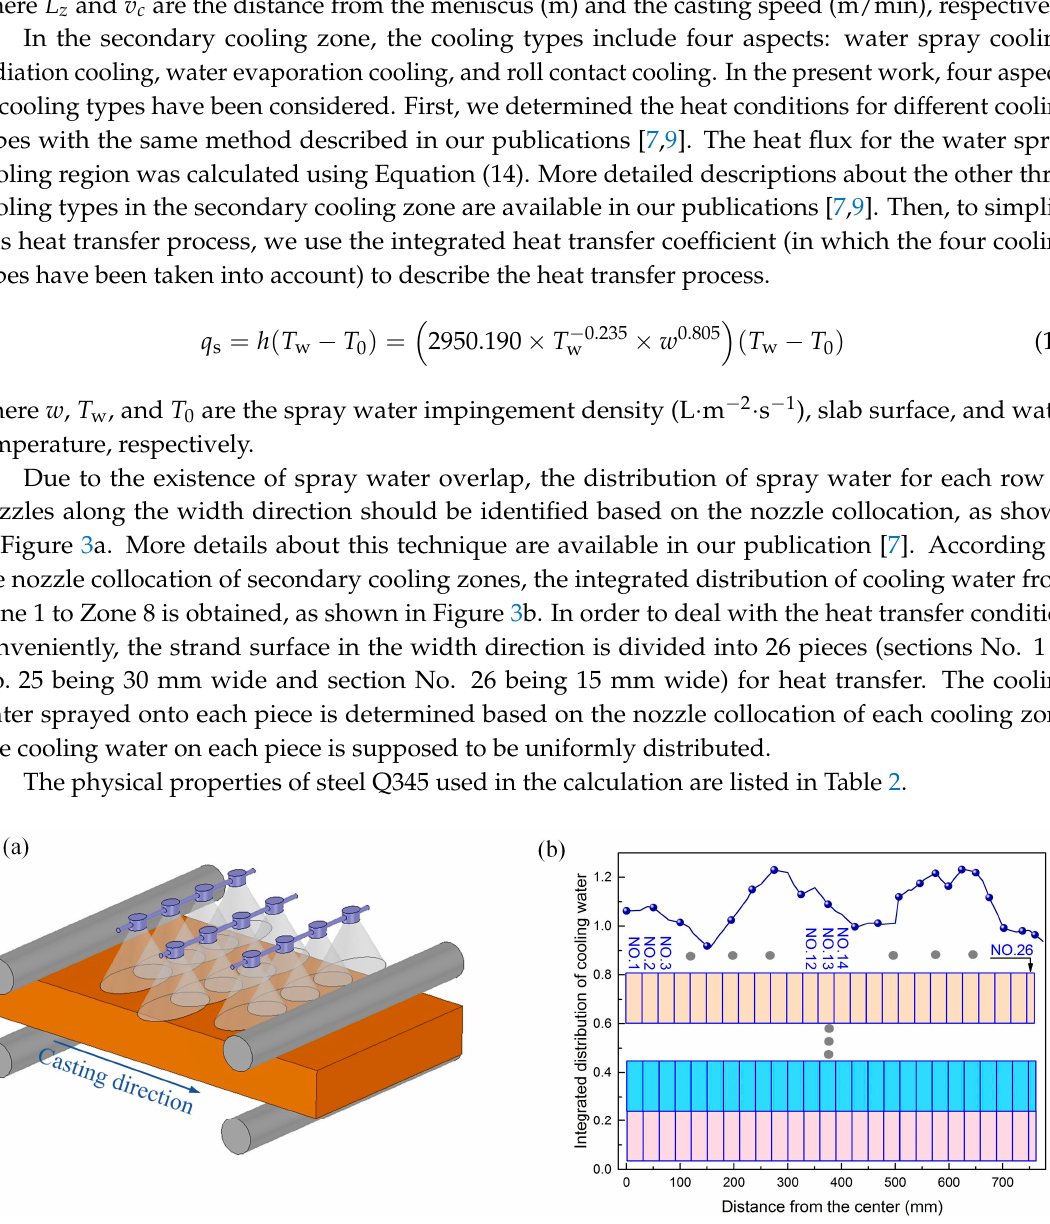
Figure 3. ( a ) Schematic of nozzle collocation; ( b ) integrated distribution of cooling water from Zone 1 to Zone 8.